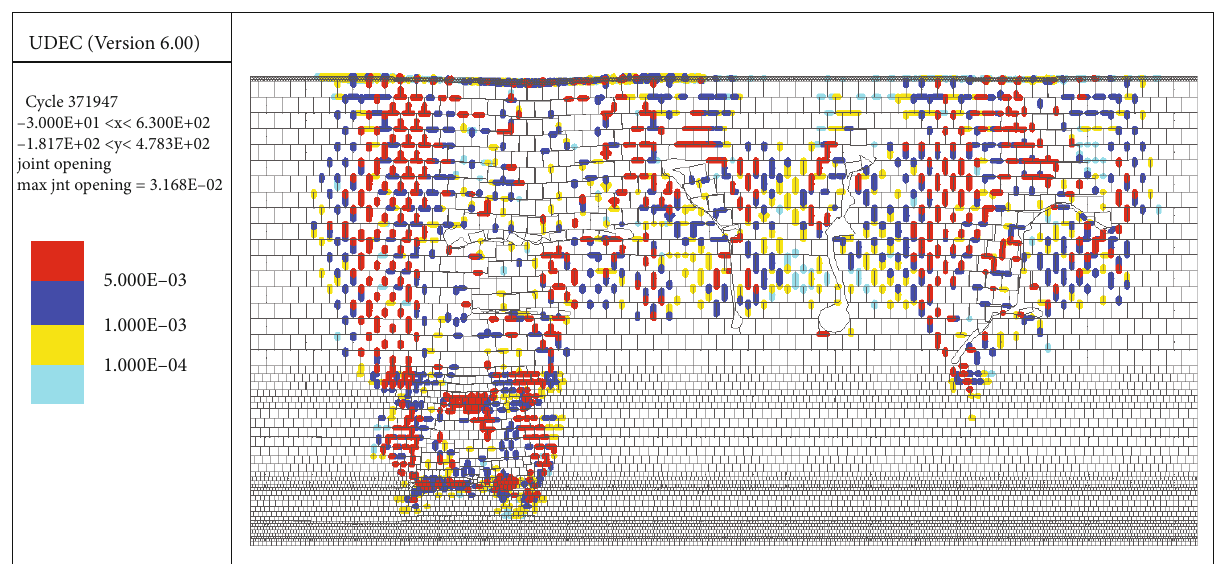
Figure 6: Mining-induced fracture fi eld (mining distance is 180 m in 4# coal